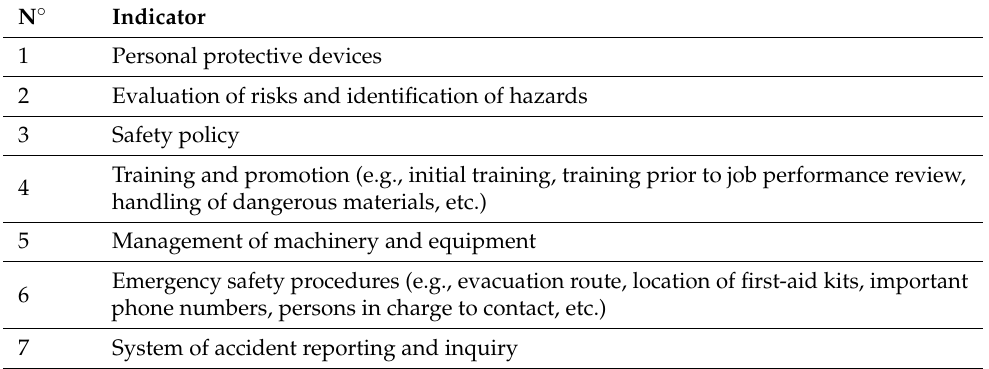
Table 3. Indicators used in the SHASSIC tool [20].